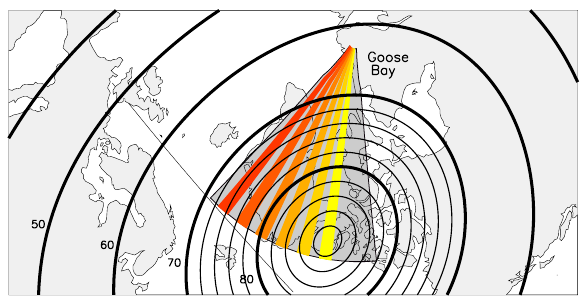
Fig. 1. Map showing the field of view of the Goose Bay radar as used in this study. Highlighted are the 6 beams used - beam 4 (yel- low), through beams 6, 8, 10, and 12, to beam 14 (red). The thick black lines represent contours of constant Altitude-Adjusted Cor- rected GeoMagnetic (AACGM) latitude at 10 ◦ intervals (latitudes as shown). The thinner black lines represent contours of constant AACGM latitude at 2 ◦